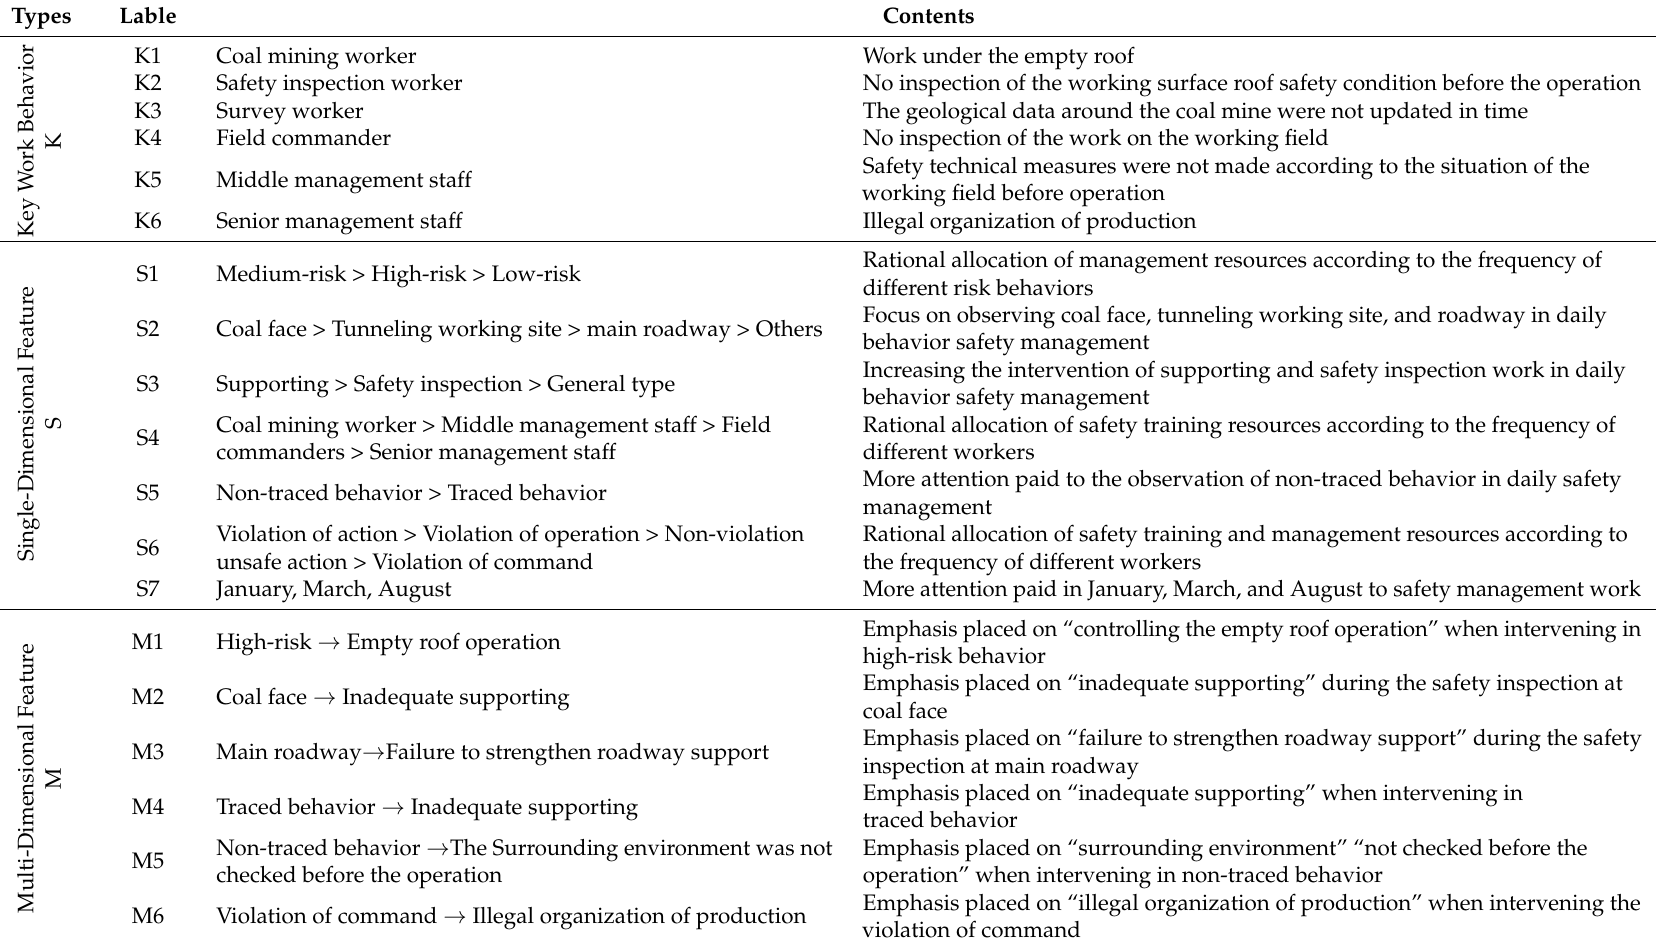
Table 3. List of miners’ unsafe behavior-targeted intervention